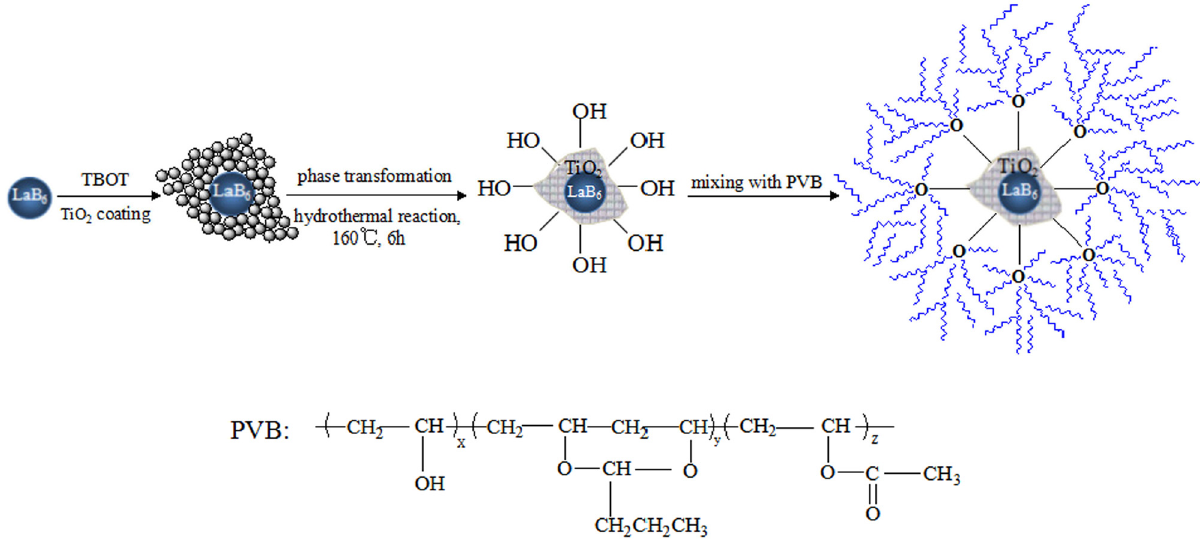
Figure 1: The schematic diagram of fabrication of LaB 6 @TiO 2 NPs and LaB 6 @TiO 2 - PVB nanocomposite fi lms.